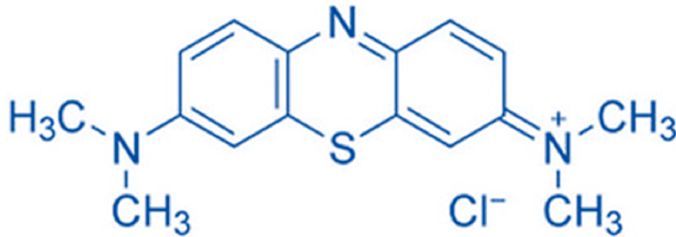
Figure 8. Chemical Structure of Methylene Blue [44].